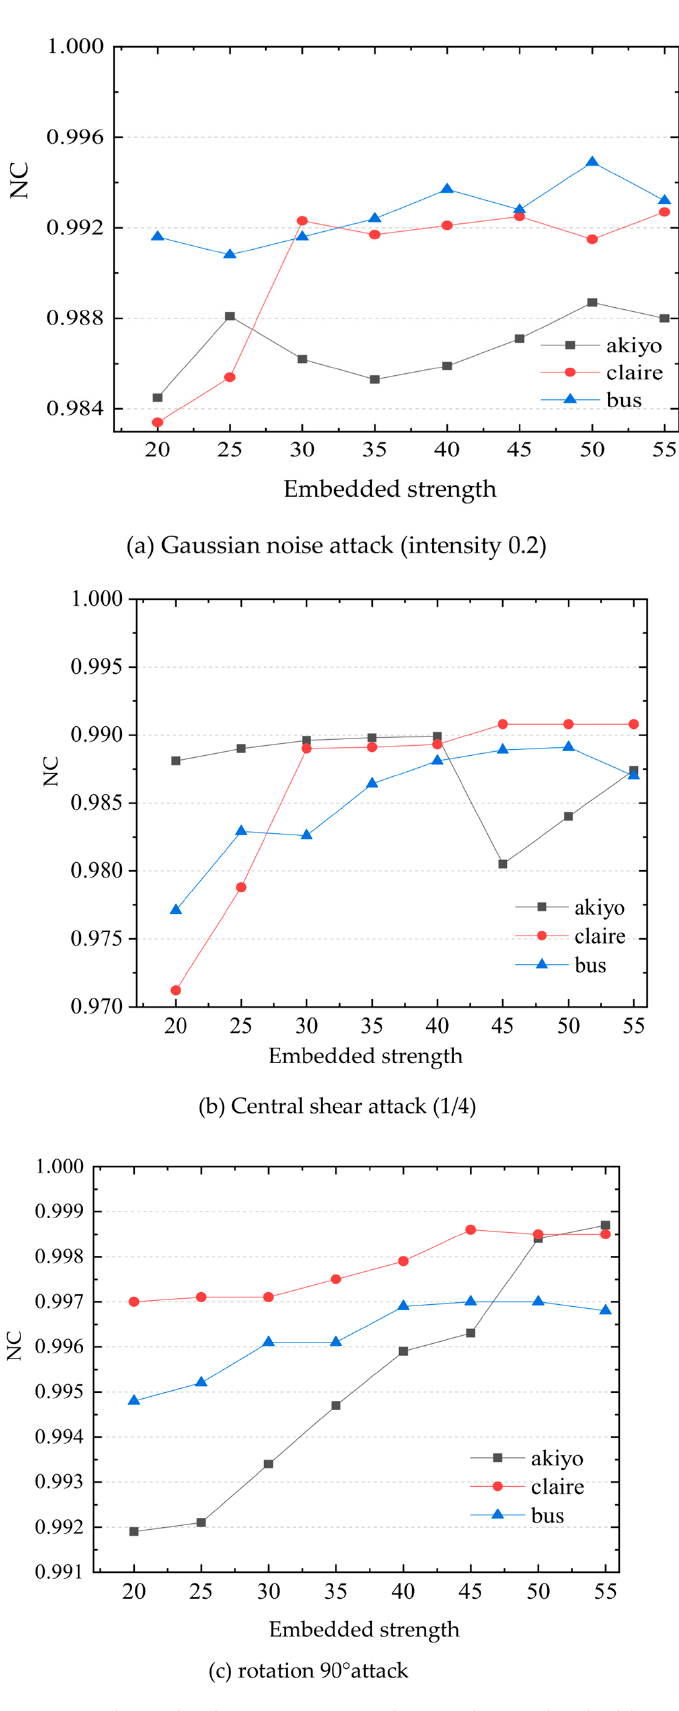
Figure 7. Relationship between watermark NC values and embedding strength under different at- tacks.